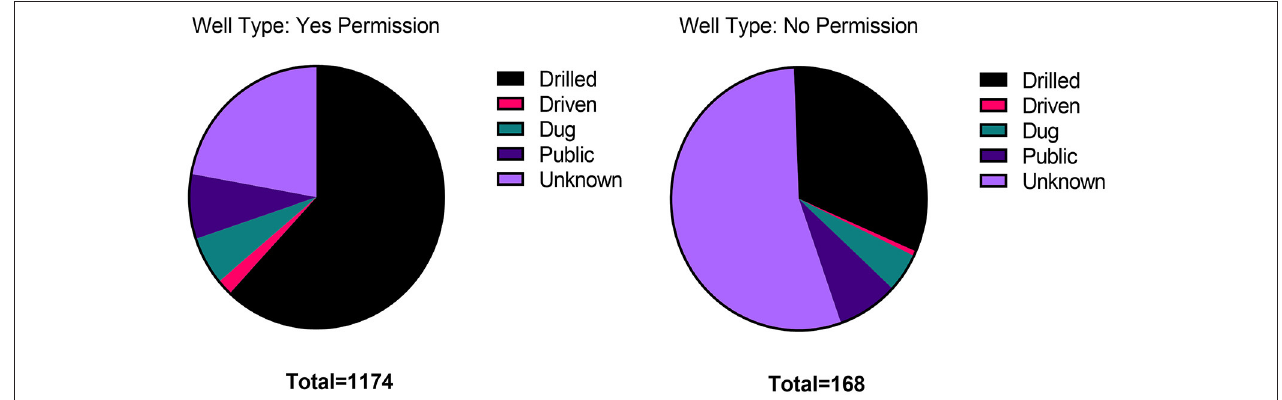
FIGURE 7 | Permissions on Anecdata. A permission form was included in the datasheet for the “All About Arsenic” project, so that private data could be shared with state agencies charged with protecting public health. People who did not know much about their wells tended to not give permission for sharing any data.